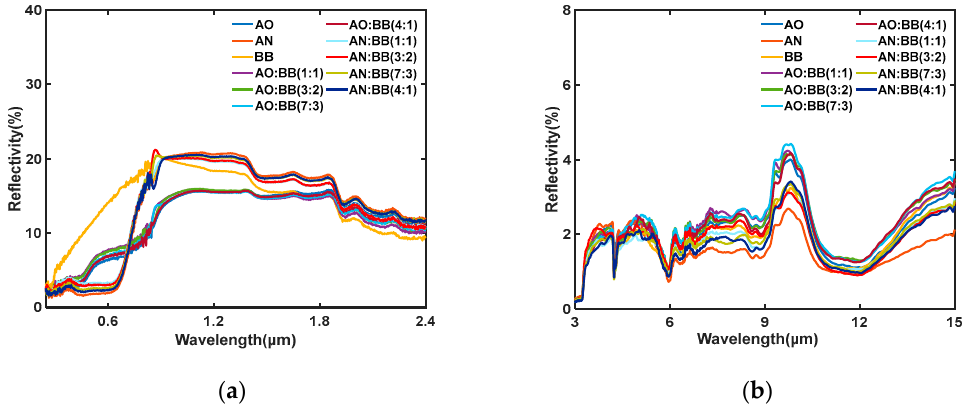
Figure 8. Spectral reflectivities of single-germplasm biospores and compound bioaerosols. ( a ) Reflectivities in the 0.25–2.4 μ m wavelength range. ( b ) Reflectivities in the 3–14 μ m wavelength range.